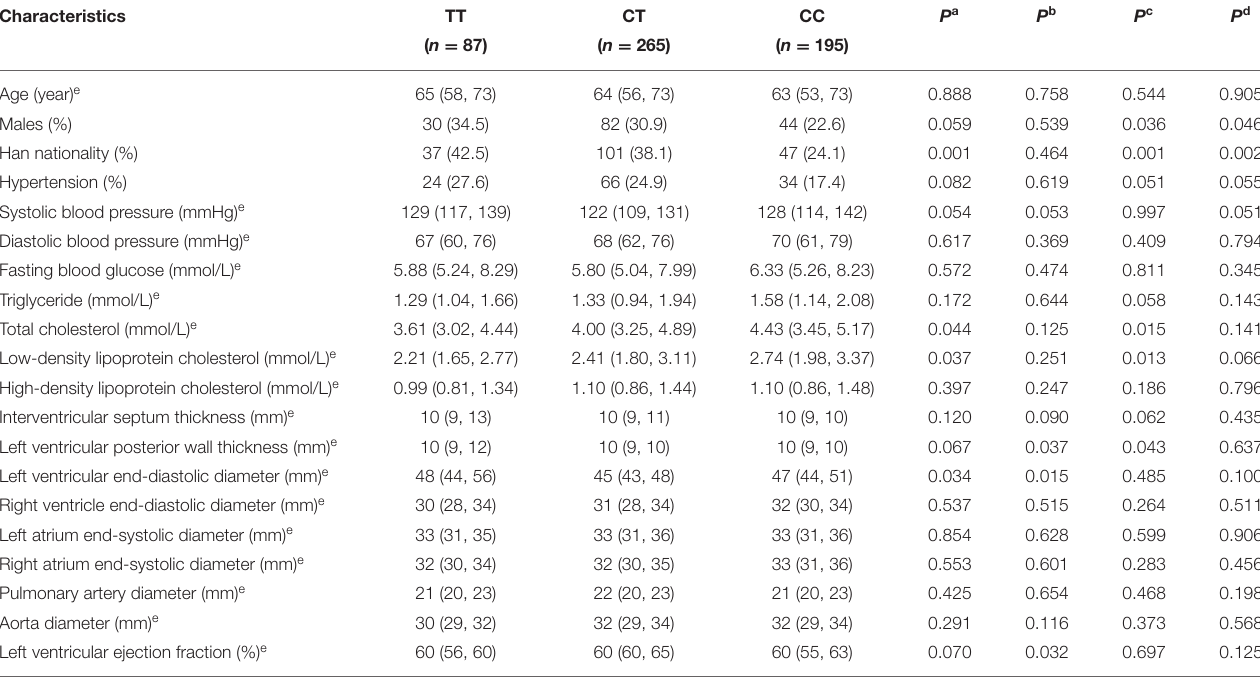
TABLE 5 | Basic characteristics of middle-aged and elderly with different genotypes of rs189037.